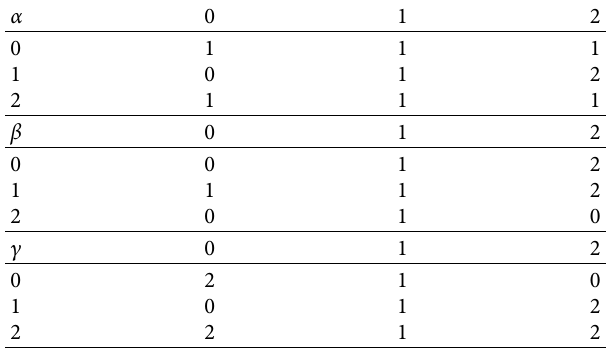
Table 4: Cayley tables for the binary operations “ α , β , and c